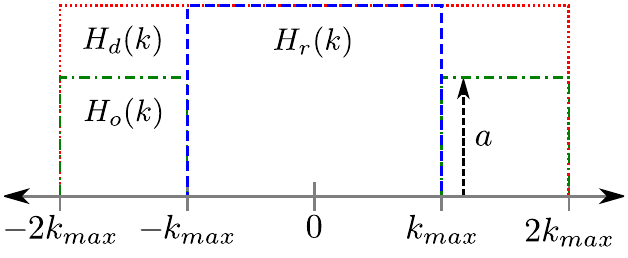
Figure 3. Different weighting functions for the sampling of k -space, where H the regularly-sampled k -space window from a single-echo sequence, H doubly-sampled k -space window for twice the resolution, and H half of k -space that would be sampled by the second echo in a multi-echo sequence with